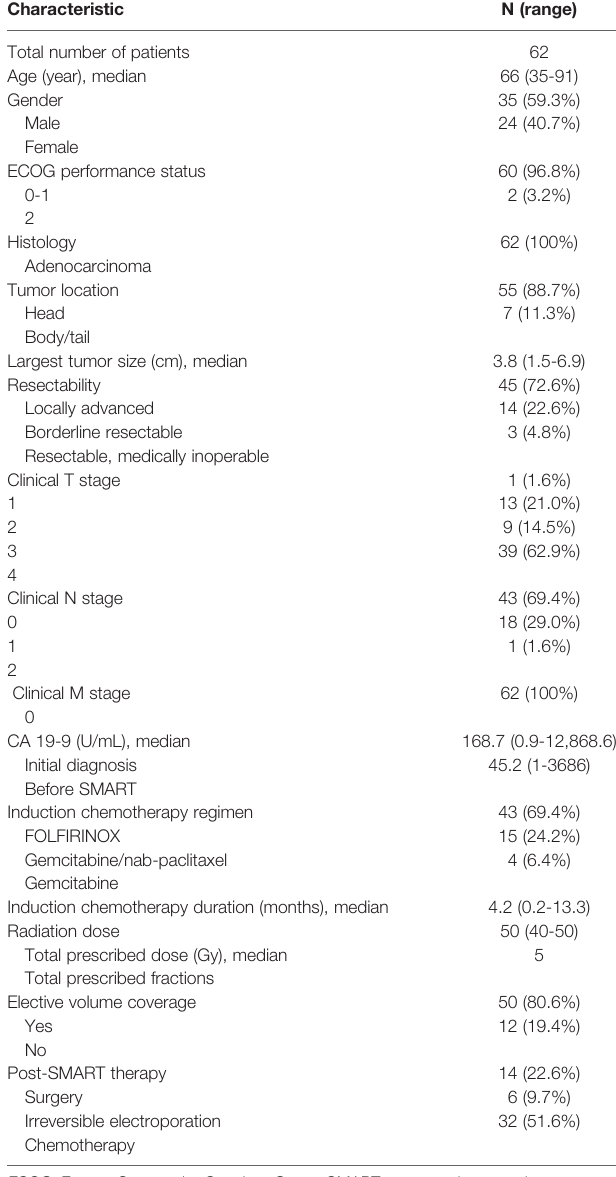
TABLE 1 | Patient, tumor, and treatment characteristics.